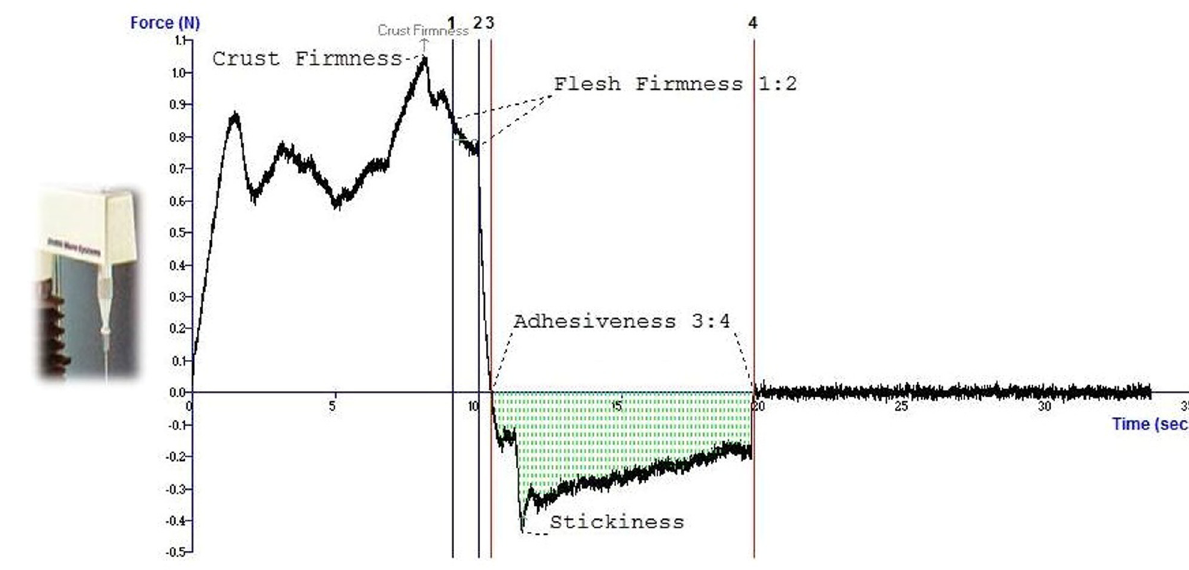
Figure 2: Example of a texture analysis obtained for sample Raspberry & Mint, making the puncture test with the P/2